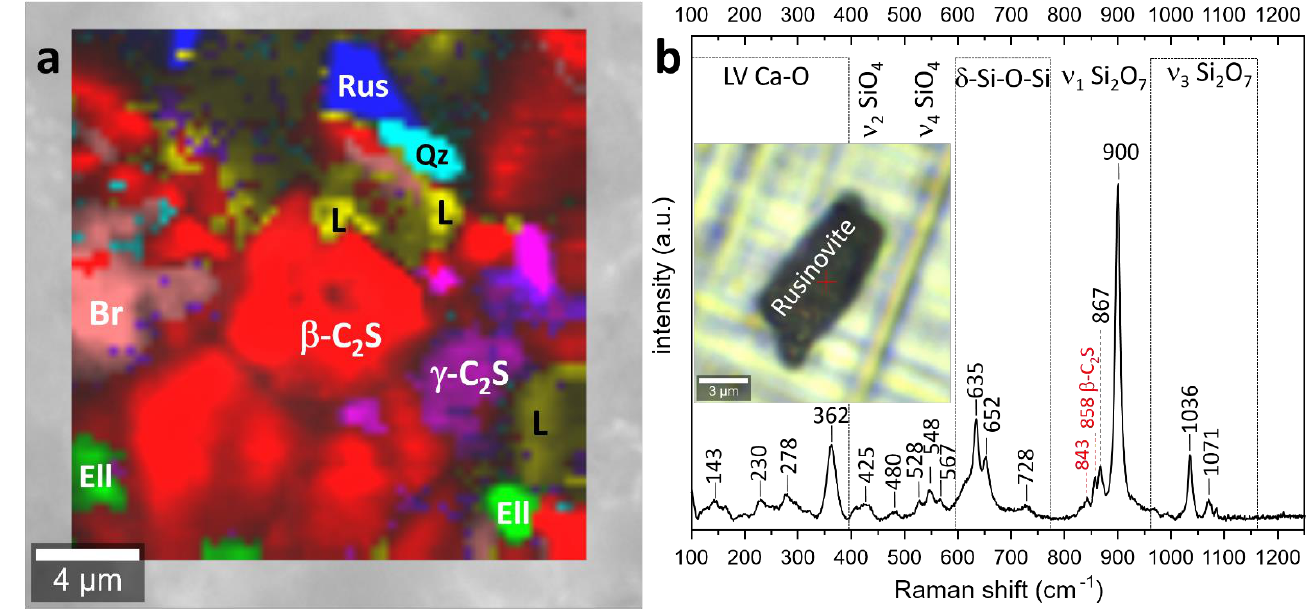
Figure 7 . ( a ) Raman image of sample D1 calcined at 1200 °C showing the phase distribution of β -C 2 S, γ -C 2 S, bredigite (Br), ellestadite (Ell), rusinovite (Rus), quartz (Qz), and lime (L). ( b ) Raman spectrum of rusinovite taken from a single crystal (10 × 4 μ m) on an Au foil.